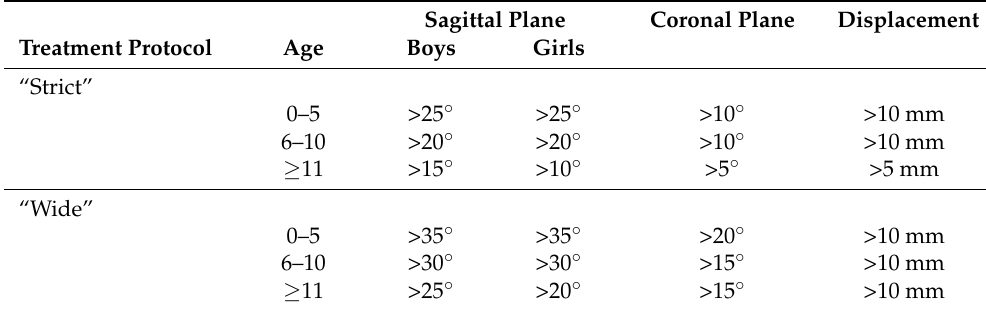
Table 2. Limits of acceptable alignment according to the “strict” and “wide”